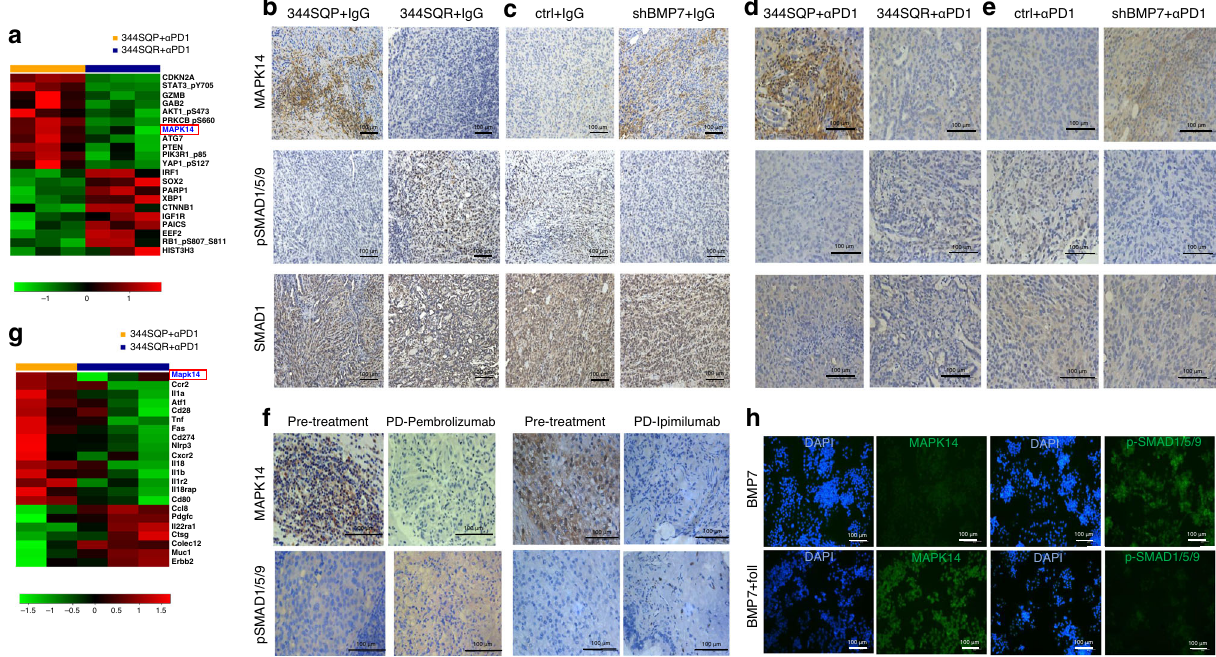
Fig. 2 BMP7 modulates MAPK14 in anti-PD1-resistant tumors and immune cells. a Reverse phase protein array (RPPA) results on expression levels and activation status of 243 proteins in 344SQP ( n = 3 biologically independent samples) and 344SQR ( n = 3 biologically independent samples) tumors treated with anti-PD1(10 mg/kg). Normalized data were fi rst log2-transformed (log2(x + 1)). Proteins expressed at different levels between groups (downregulated proteins in green and upregulated proteins in red) were identi fi ed by a P value of <0.05 obtained from LIMMA ’ s moderated t statistic (MAPK14, * p = 0.0107). b Representative images of immunohistochemical stains for MAPK14, SMAD1/5/9 phosphorylation, and SMAD1 in formalin- fi xed paraf fi n-embedded tissue sections from 344SQP and 344SQR tumors treated with IgG (10 mg/kg). Scale bar, 100 μ m (×40 magni fi cation). Data shown are representative of two reproducible independent experiments of three biologically independent samples. c , Representative images of immunohistochemical stains for MAPK14, SMAD1/5/9 phosphorylation, and SMAD1 in formalin- fi xed paraf fi n-embedded tissue sections from BMP7- knockdown tumors treated with IgG (10 mg/kg) compared with control (scale bar, 100 μ m) (×40 magni fi cation). Data shown are representative of two reproducible independent experiments of three biologically independent samples. d Representative images of immunohistochemical stains for MAPK14, SMAD1/5/9 phosphorylation, and SMAD1 in formalin- fi xed paraf fi n-embedded tissue sections from 344SQP and 344SQR tumors treated with anti-PD1 (10 mg/kg). Scale bar, 100 μ m (×40 magni fi cation). Data shown are representative of two reproducible independent experiments of three biologically independent samples. e Representative images of immunohistochemical stains for MAPK14, SMAD1/5/9 phosphorylation, and SMAD1 in formalin- fi xed paraf fi n-embedded tissue sections from BMP7-knockdown tumors treated with anti-PD1(10mg/kg) compared with control (scale bar, 100 μ m) (×40 magni fi cation). Data shown are representative of two reproducible independent experiments of three biologically independent samples. f Representative images of immunohistochemical stains for MAPK14 and SMAD1/5/9 phosphorylation in formalin- fi xed paraf fi n-embedded tissue sections from two patients collected before treatment and at the time of disease progression on pembrolizumab or ipimilumab. Scale bar, 100 μ m (×40 magni fi cation). Data shown are representative of two reproducible independent experiments. g Nanostring immune panel results for 770 genes in tumor-in fi ltrating leukocytes (TILs) collected from 344SQP ( n = 2 biologically independent samples) and 344SQR ( n = 3 biologically independent samples) tumors treated with anti- PD1(10 mg/kg). Genes expressed at different levels between groups (downregulated genes in green and upregulated genes in red) were identi fi ed by a P value of <0.05 obtained from LIMMA ’ s moderated t statistic (MAPK14, p = 0.0047). h Immuno fl uorescence analysis of MAPK14 and SMAD1/5/9 phosphorylation (green) in the macrophage cell line RAW 264.7 at 24 h after treatment with BMP7 (250 ng) or BMP7 plus follistatin (foll) (250 ng). DAPI (blue) was used to stain cellular nucleus. Data shown are representative of three reproducible independent experiments. Scale bar, 100 μ m (×40 magni fi